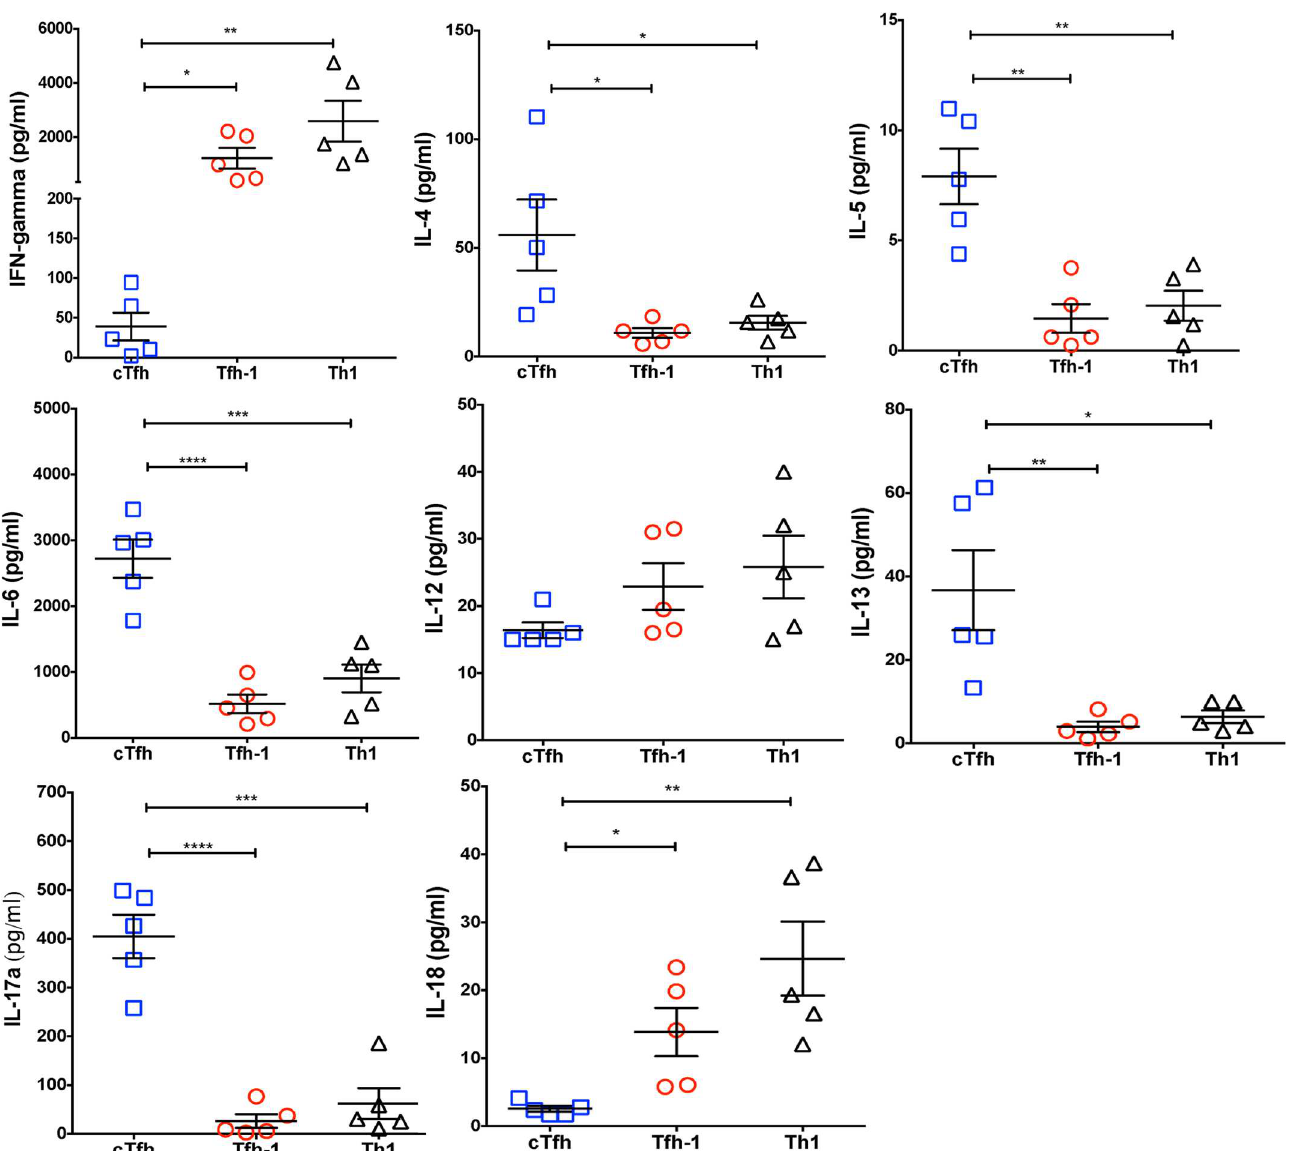
Fig 15. Secreted cytokine profiles of T cell subset/na ï veB cell co-cultures. PBMCs of U.S. adults (n = 5) were FACs-sorted into na ï veB cells (CD19+CD21+IgD+), cTfh cells (CD4+PD-1+CXCR5+CXCR3-), Tfh-1 cells (CD4+PD-1+CXCR5+CXCR3+) and Th-1 cells (CD4+PD-1+CXCR5- CXCR3+). Autologousna ï veB cells were cultured for 2 days with each T cell subset in the presenceof SEB, or with SEB alone.Shown are cytokine concentrations in supernatants at 2 days. p values were determined by pairedStudent’s t test with Bonferroni adjustments where appropriate. **** P < 0.0001, *** P < 0.001, ** P < 0.01, * P < 0.05,ns = not significant.